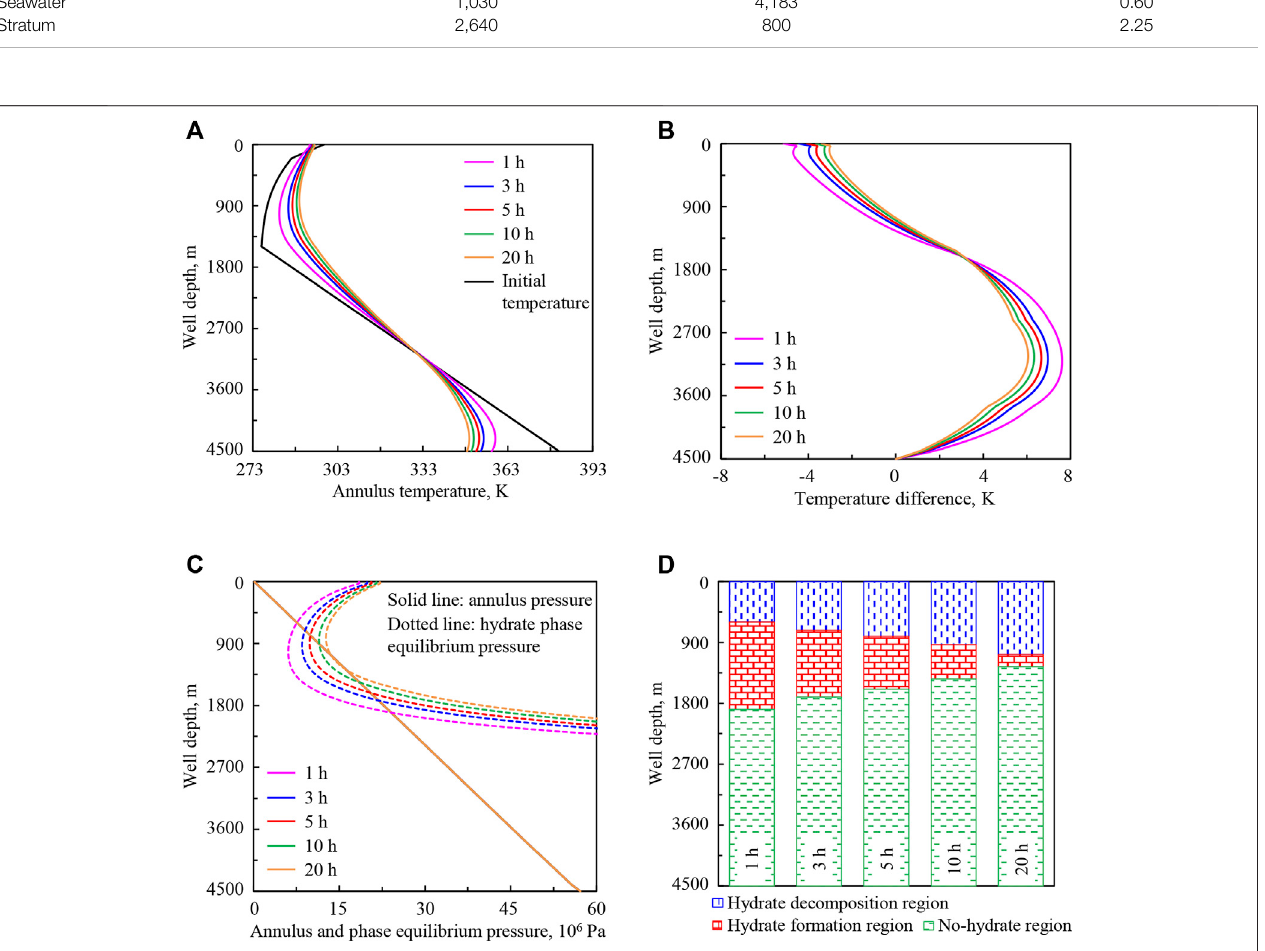
FIGURE 6 | Variation regularities of wellbore temperature fi eld, pressure fi eld, and hydrate formation region in deep-water drilling under different circulation times: (A) annulus temperature, (B) temperature difference between the drilling fl uid in annulus and in drill string, (C) annulus pressure and phase equilibrium pressure, (D) hydrate formation region. The solid lines under different circulation times in (C) are overlapped.